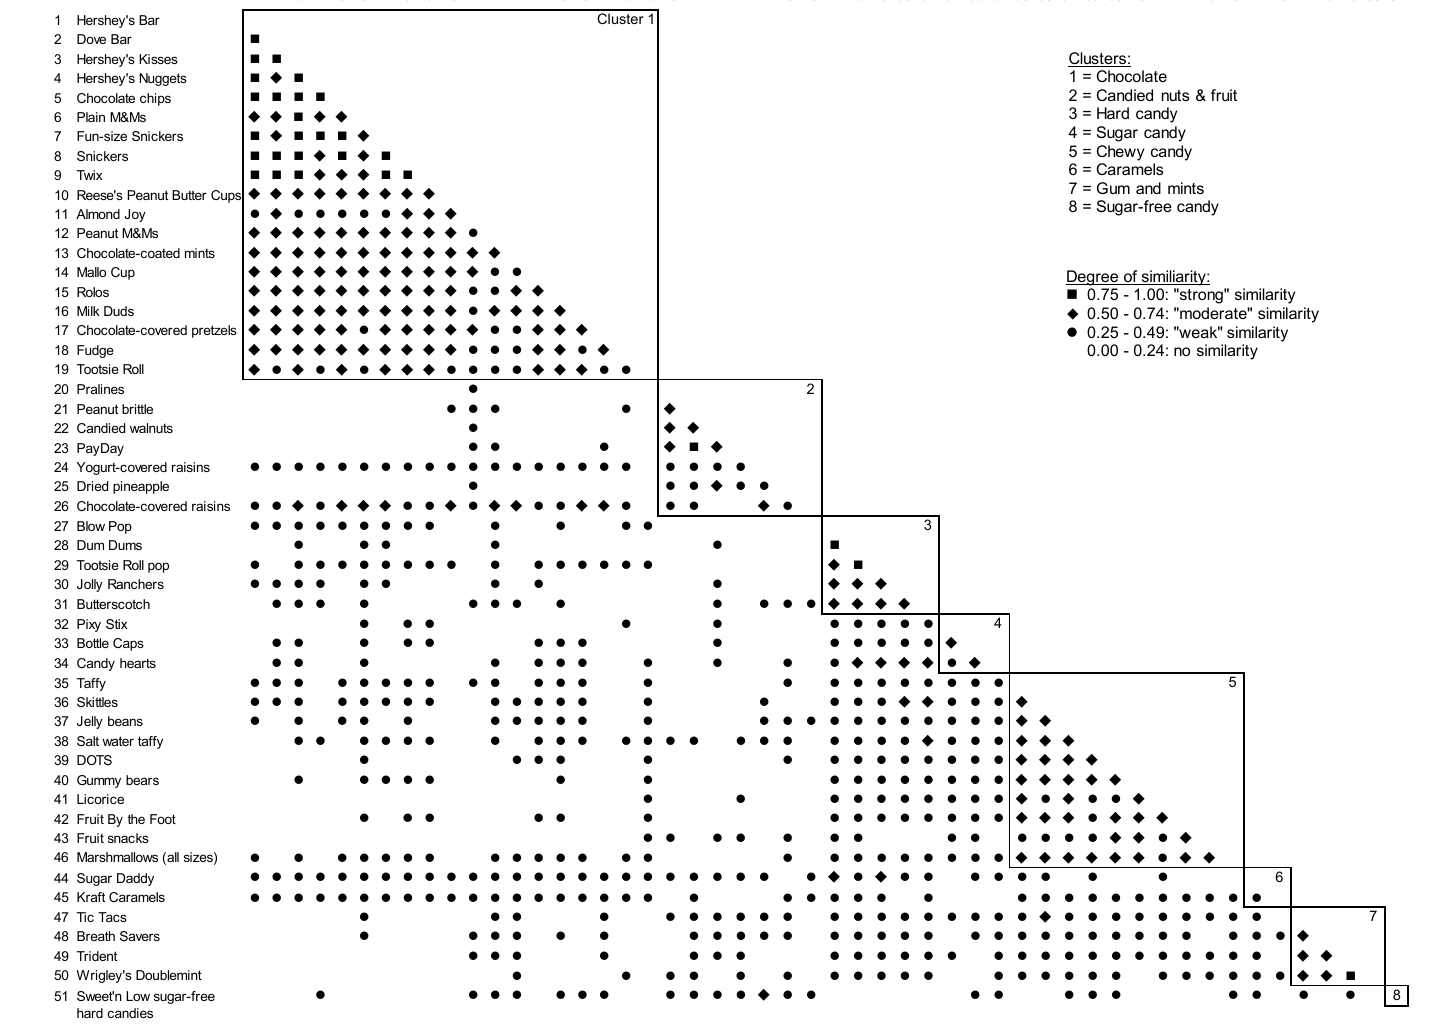
Figure 2. Similarity matrix of children’s card sort of 51 candy items into piles ( n = 42).